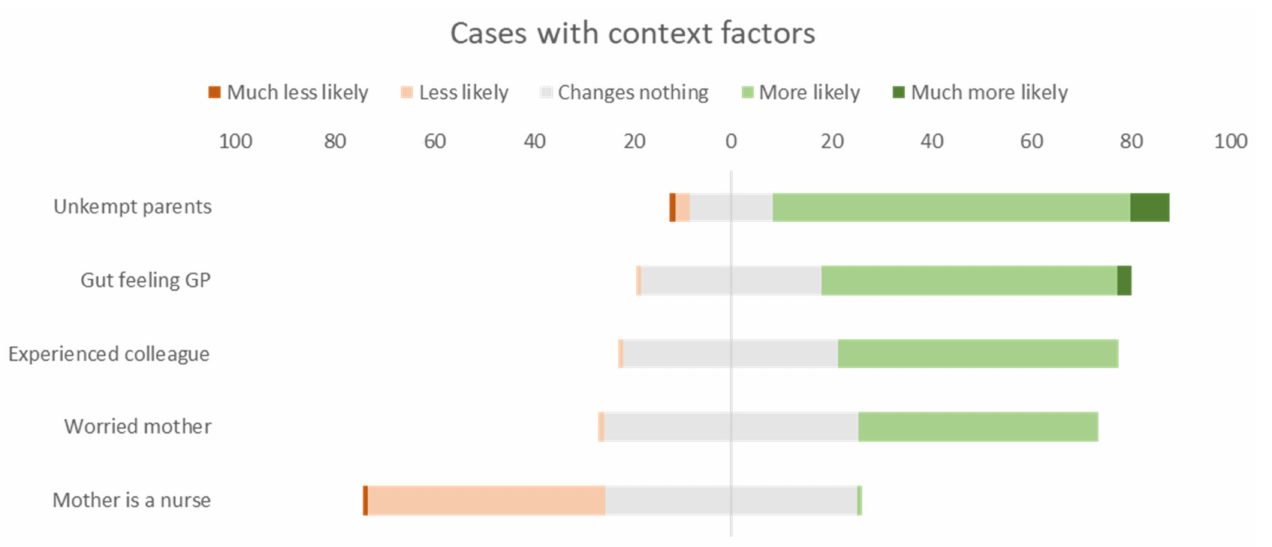
Figure 1. Overall answers to cases with medical factors in percentages.